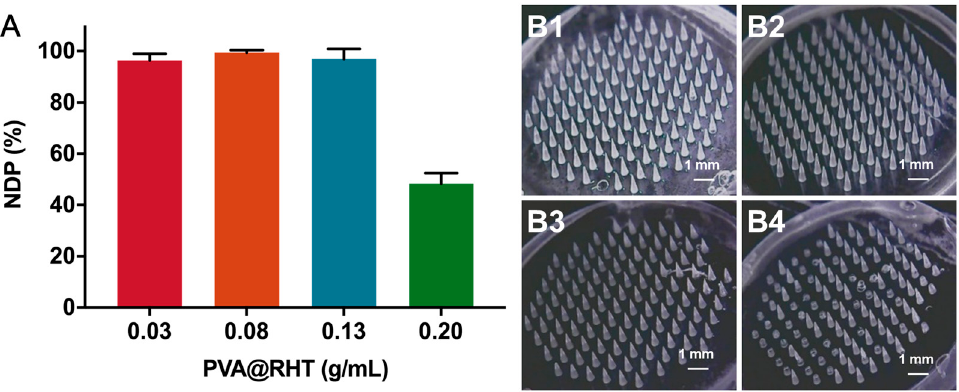
Figure 7. The influence of PVP@RHT feeding concentration on the ( A ) DNP ( n = 3) and ( B ) morphol- ogy of particle-embedded gas-propelled MNs: ( B1 ) 0.03 g/mL, ( B2 ) 0.08 g/mL, ( B3 ) 0.13 g/mL, and ( B4 ) 0.20 g/mL.